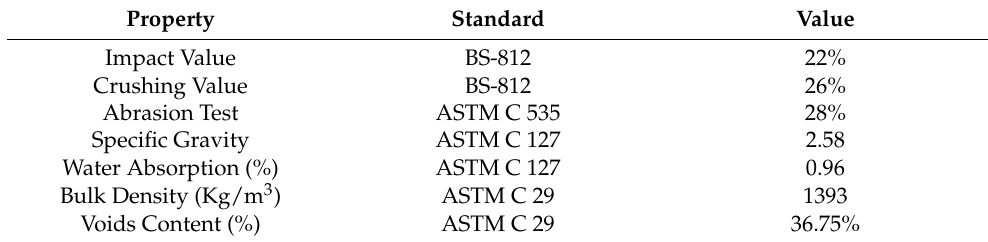
Table 4. Physical Properties of Aggregates.